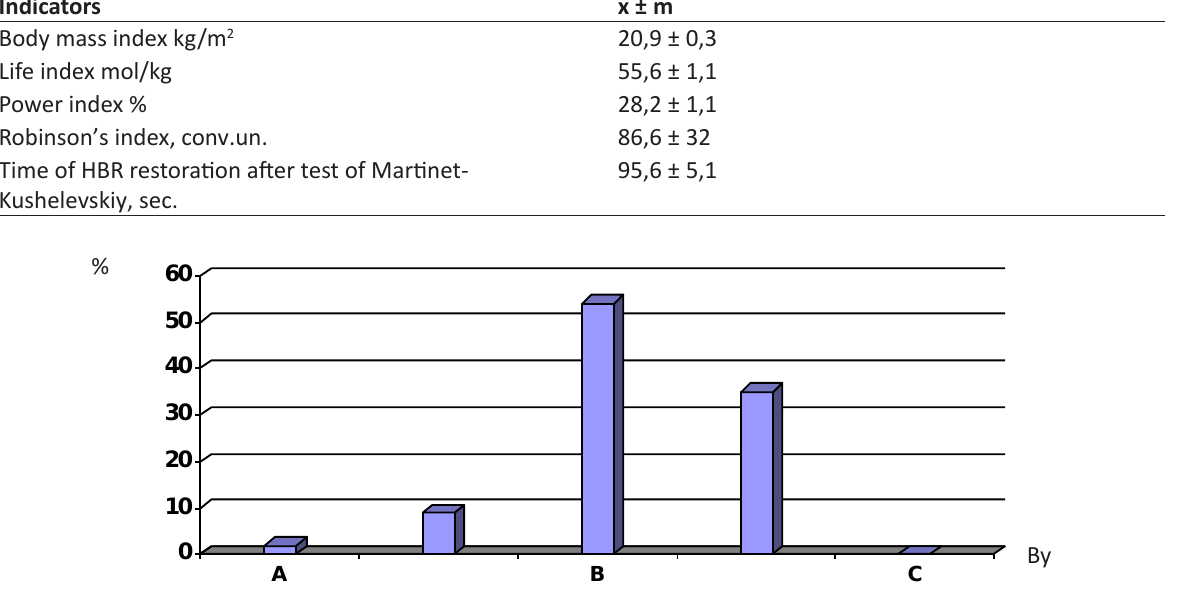
Fig. 5. Distribution of biological age in % of Kharkov national medical university girl students: By – biological age; A – very slow process; B – corresponds to population standard; C- very quickly. Table 3. Factorial structure of integral indicators of 1 st -2 nd year girl